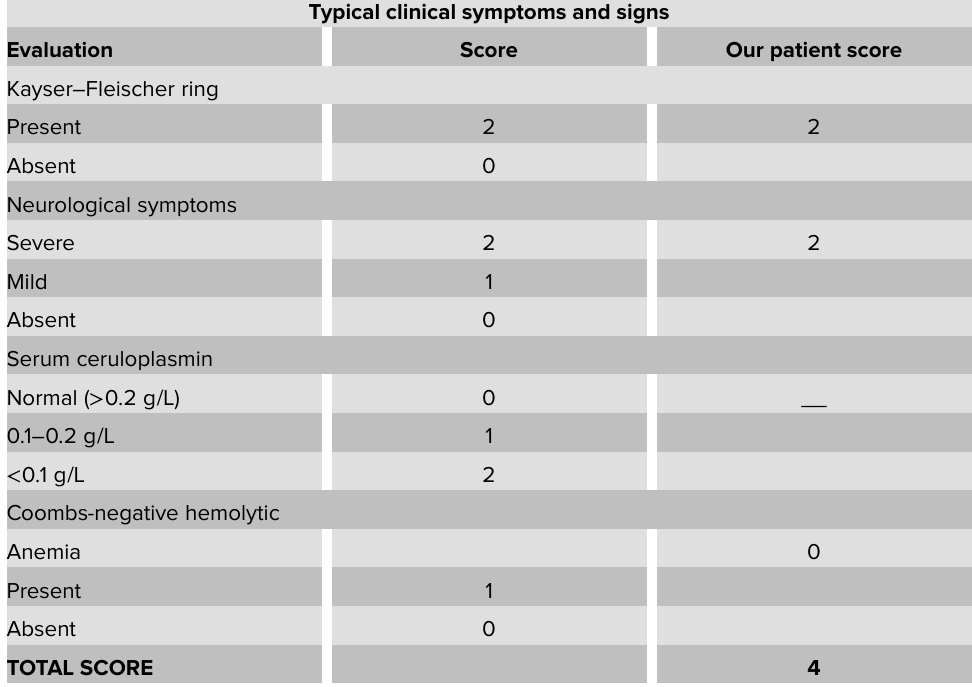
TABLE 2: Scoring systems developed at the 8 th International Meeting on Wilson’s disease in Leipzig 2001.